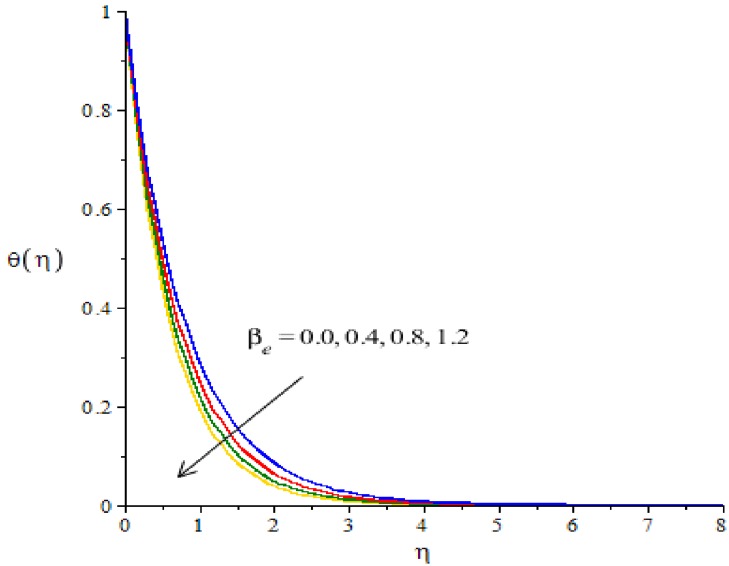
Figure 10. The graphical view of temperature versus β e .